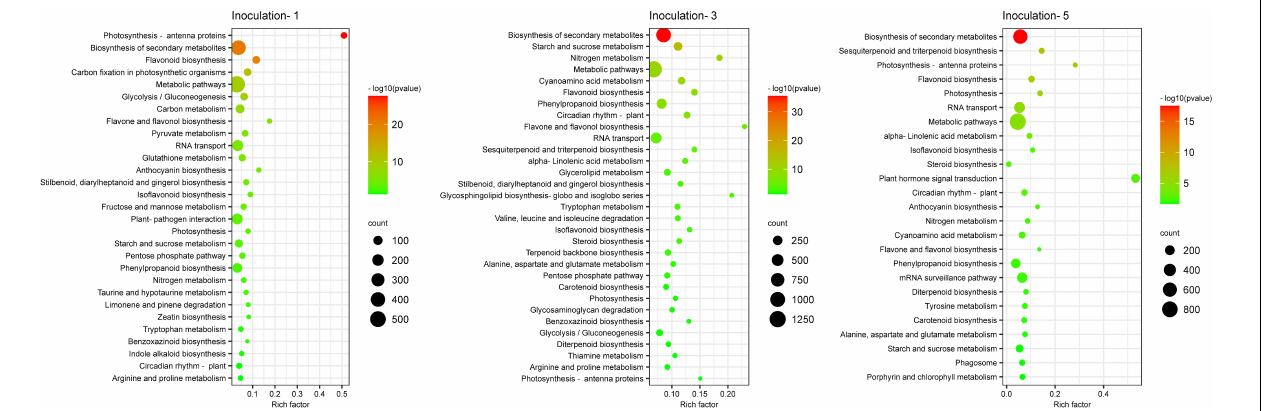
FIGURE 7 | Gene Ontology classification of differential expression